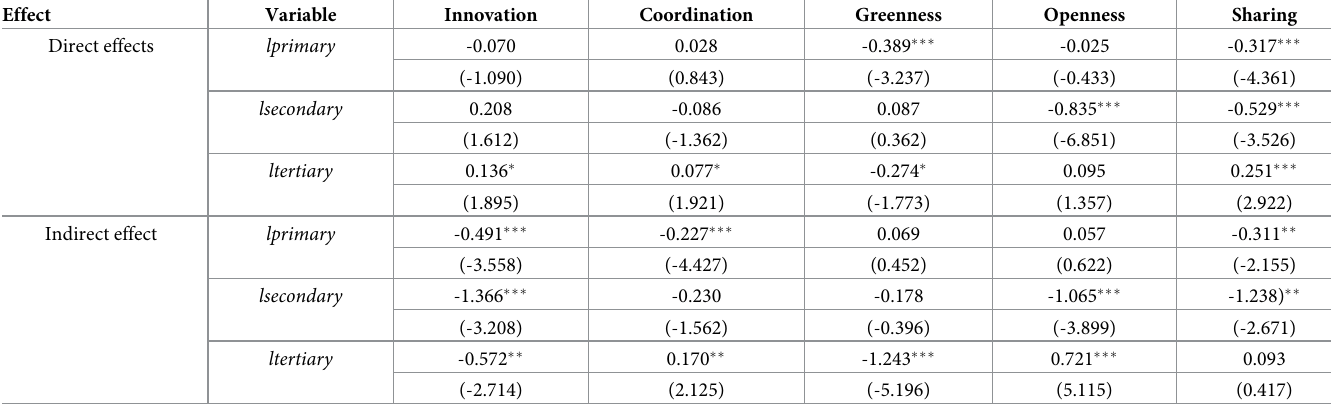
Table 8. Decomposition table of spatial effect of SDM under two-dimensional fixed effects of space and time for sub-indices of high-quality economic